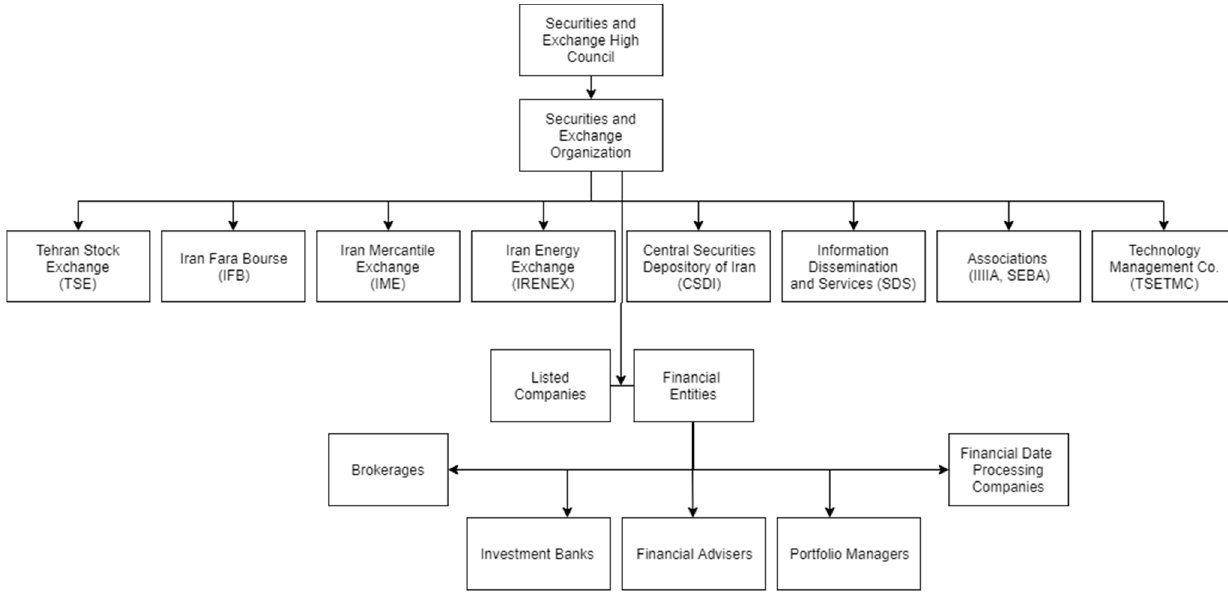
Figure 1. Iran’s capital market